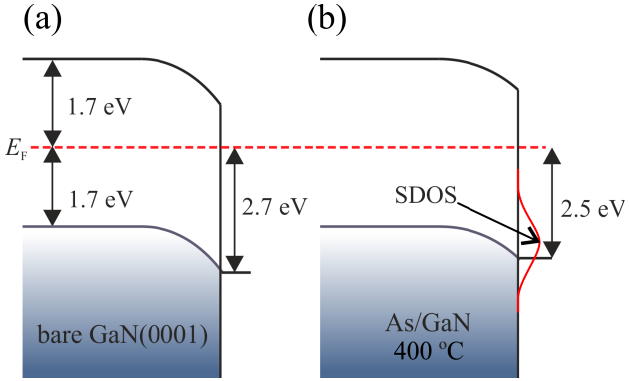
Figure 33. Energy diagrams for ( a ) bare GaN(0001) and ( b ) annealed As ‐ film ‐ covered GaN(0001) surfaces at 400 °C.